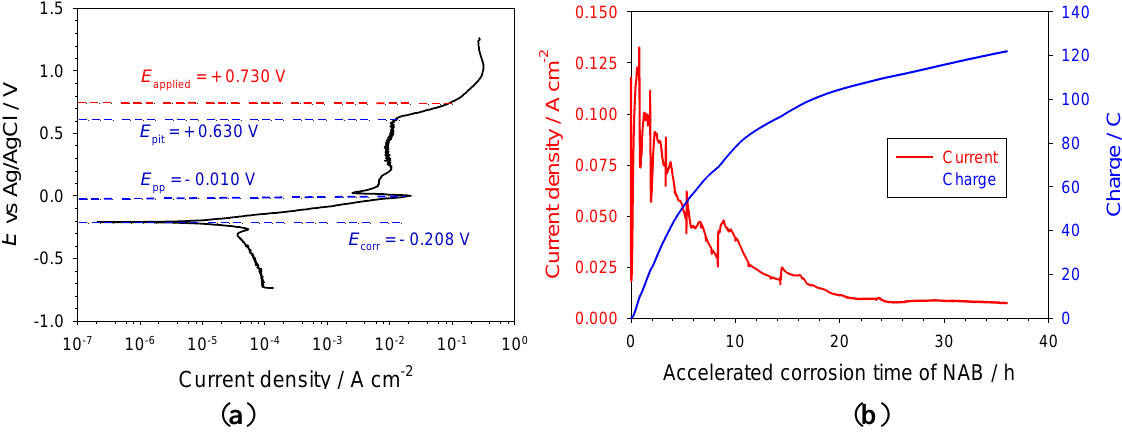
Figure 8. ( a ) Polarisation behaviour at scan rate of 0.150 mV·s −1 ; and ( b ) electrochemical response with accelerated corrosion time at applied potential of +0.730 V for NAB pencil electrode in 3.5% NaCl